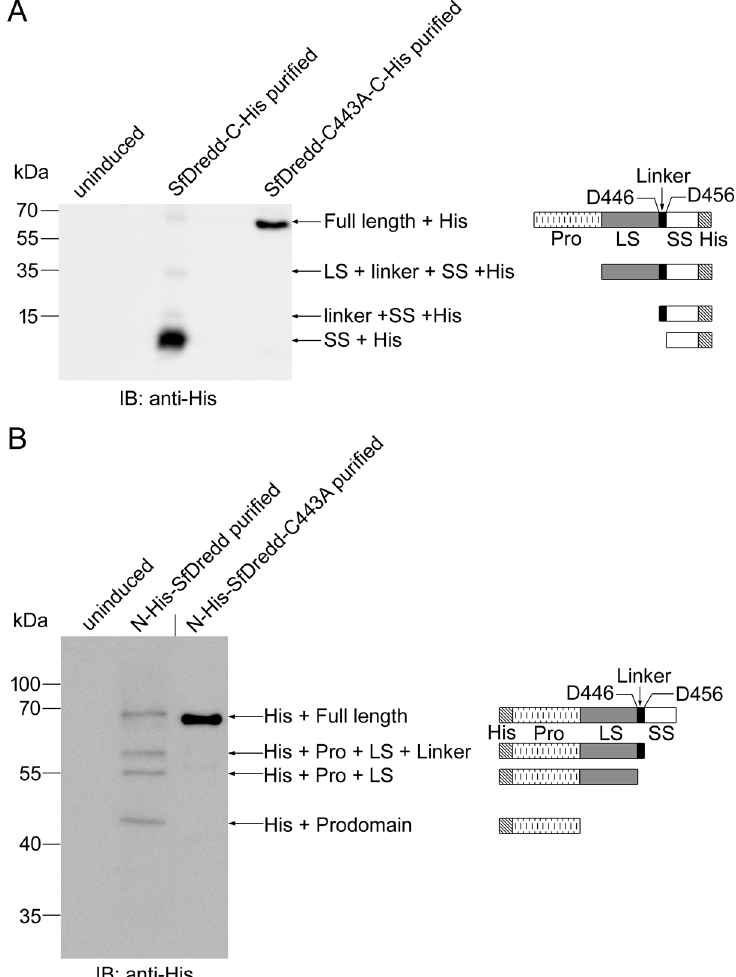
were expressed and purified from E . coli and detected by immunoblotting using antibody against His-tag following SDS-PAGE. Diagrams showing the full length SfDredd and cleaved subunits are on the right. A short vertical black line was used to indicate where lanes were removed and separate parts of the same Western blot image were joined together. His: His-tag, Pro: prodomain, LS: large subunit, L: linker, SS: small